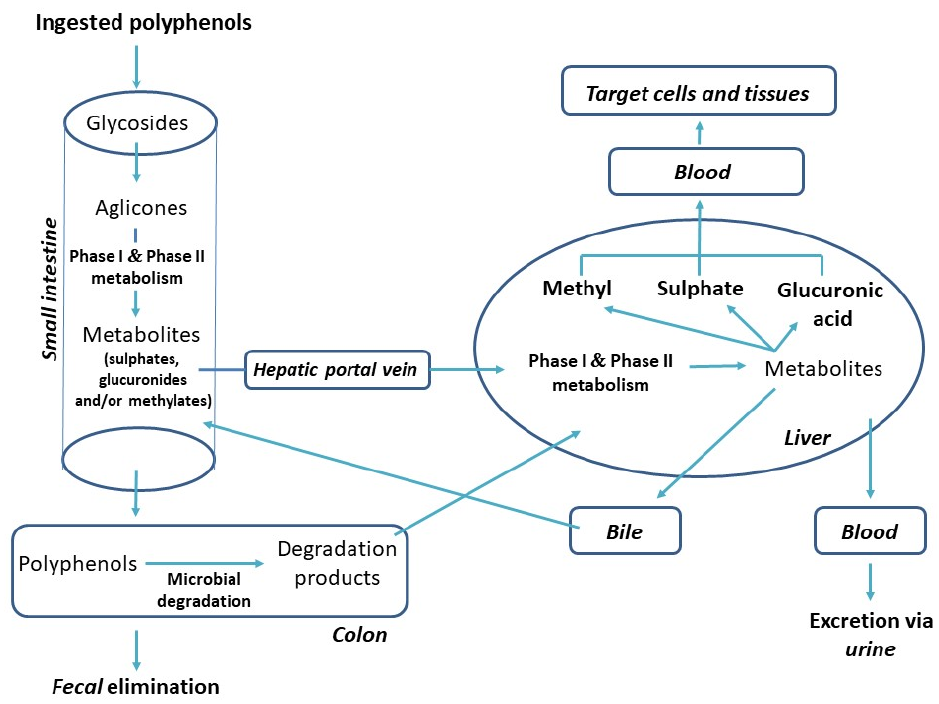
Figure 3. Biotransformation of PCs after oral intake [13].